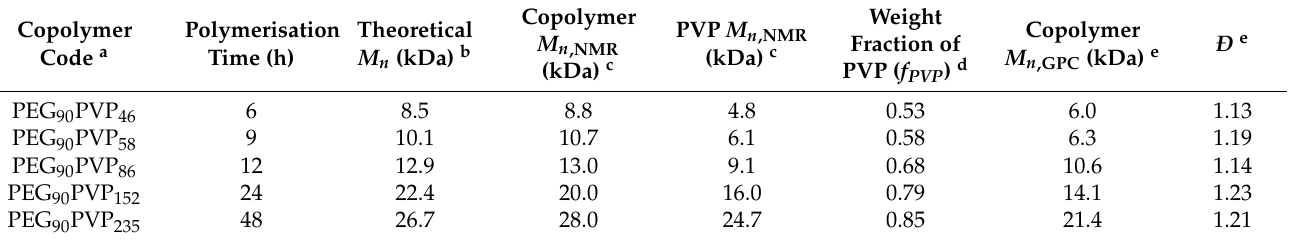
Table 1. Polymerisation time, monomer conversion, and molecular weight characteristics of the syn- thesised PEG- b -PVP copolymers.